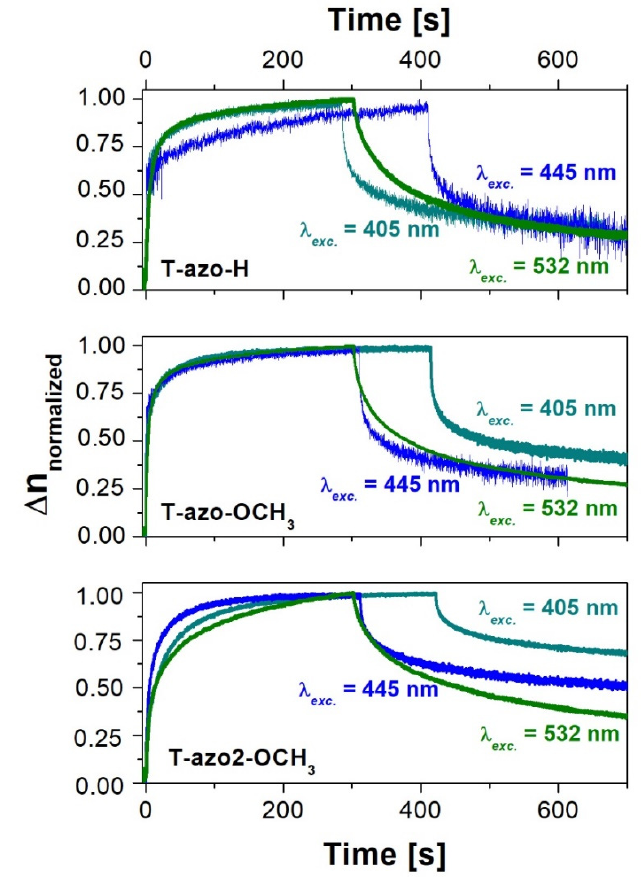
Figure 6. Birefringence growth and relaxation curves for selected thiazole–azo dyes dispersed in PMMA matrix thin films for 405 nm, 445 nm and 532 nm.